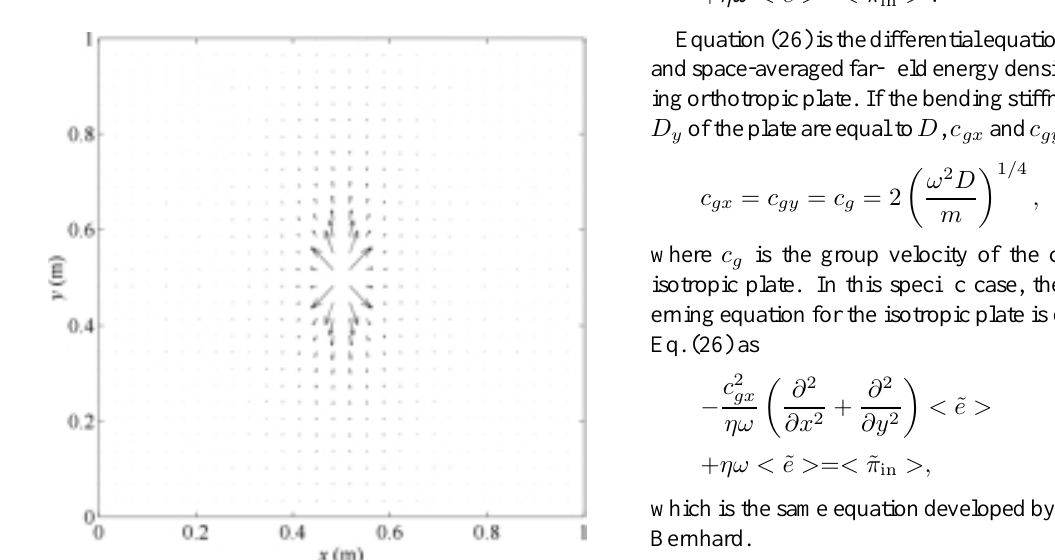
Fig. 17. The classical intensity field in the orthotropic plate when f = 5 kHz and η = 0 . 2 .